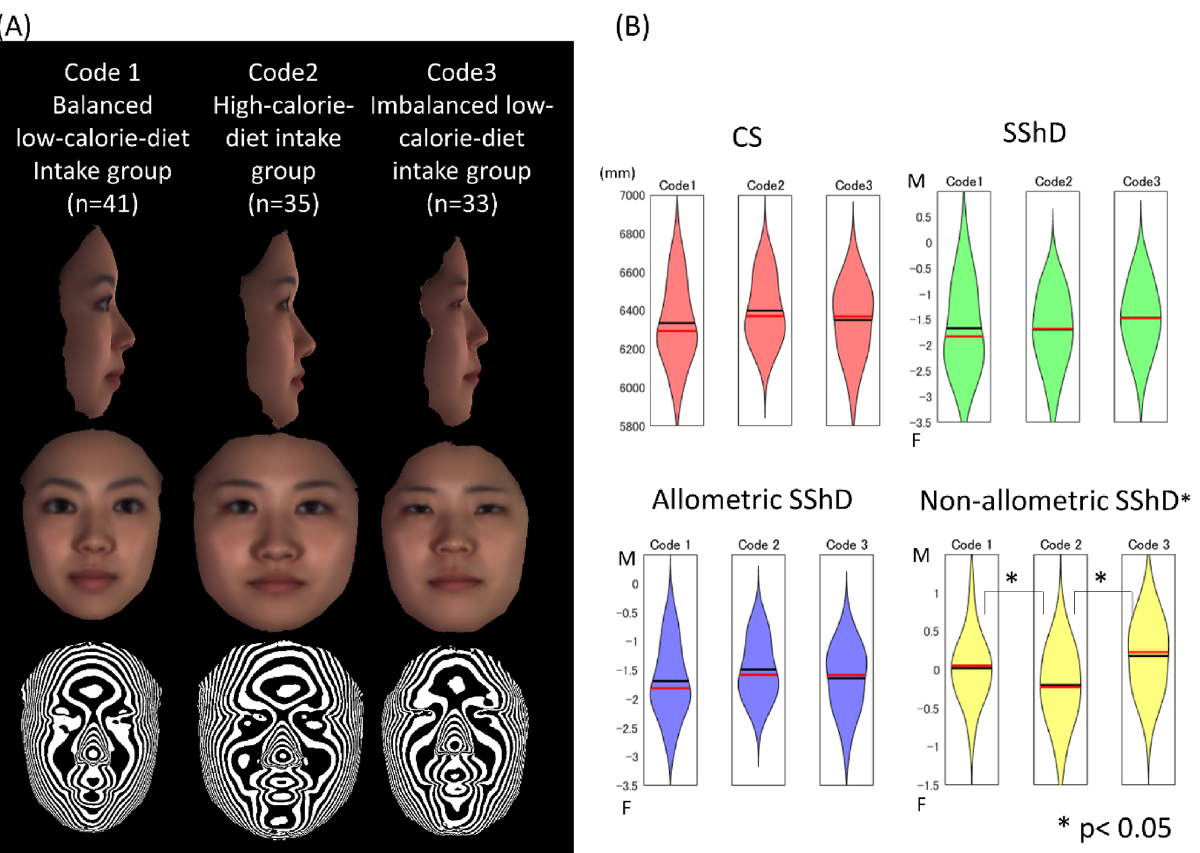
Figure 5. ( A ) The accentuated averaged faces for the three code groups determined in the present study; and ( B ) centroid size (CS), sexual shape dimorphism (SShD), allometric SShD, and non-allometric SShD. ( A ) For the computational procedure, see Tanikawa et al. 30 , where five was used as a weight to accentuate the differences among the codes. Top, lateral view; middle, frontal view; bottom, Moire image. Three facial images in Code 1, three facial images in Code 2, and two facial images in Code 3 showed insufficient data quality in the region of the ears and were thus excluded from the analysis. This insufficient data quality was due to some participants not perfectly removing their hair from around their ears, which was necessary for taking good-quality images with the 3D cameras. ( B ) M indicates hyper-masculine face, and F, hyper-feminine face. *p < 0.05 (ANOVA, Turkey-Kramer post-hoc test). A custom-made MATLAB based software (MATLAB 2021a, The MathWorks, Inc., Natick, MA) was used to create this